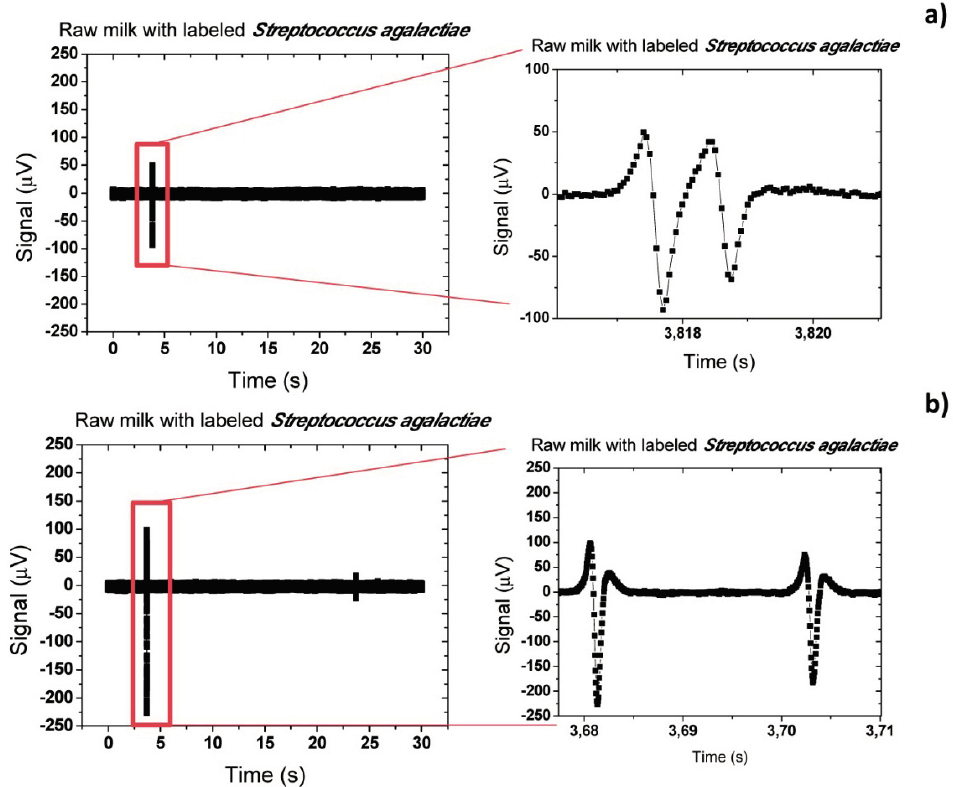
Figure 24. Acquisition signal for raw milk samples with magnetically labeled S treptococcus agalactiae cells at 50 µL/min .